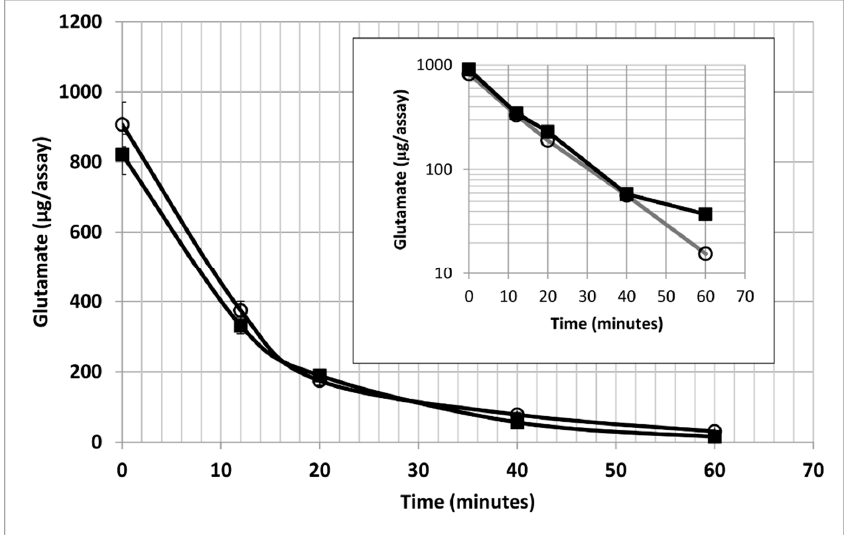
Figure 9. Glutamate uptake by ex planta B . diazoefficiens bacteroids in the absence and presence of 2 mM L -malate. The insert is a semi-log plot of the same data in the main figure. Assays performed as described in Section 4 containing 14.1 mg dry weight of bacteroids and 0.016 atm partial pressure of oxygen. Absence of l -malate, closed squares; presence of l -malate, open circles. The values are the means of six measurements plus the standard